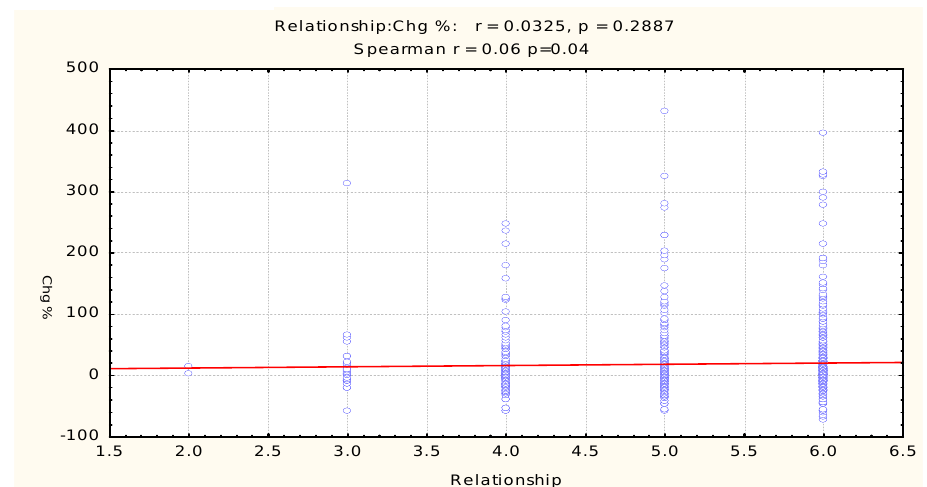
Figure 2: Scatter plot on the range of growth: -100% to +